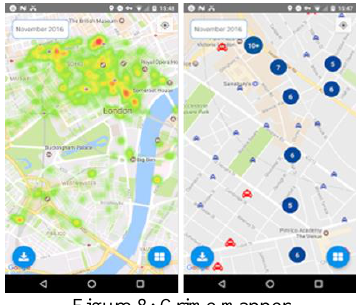
Figure 8: Crime mapper